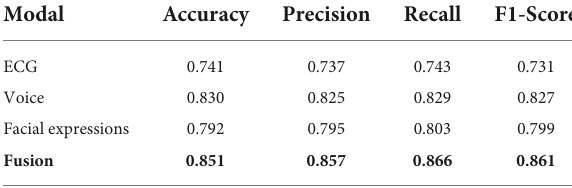
TABLE 1 Stress detection accuracy, precision, recall and F1-score using single- and multimodality